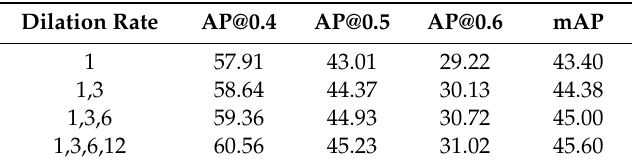
Table 5. Dilated convolution performance (%).